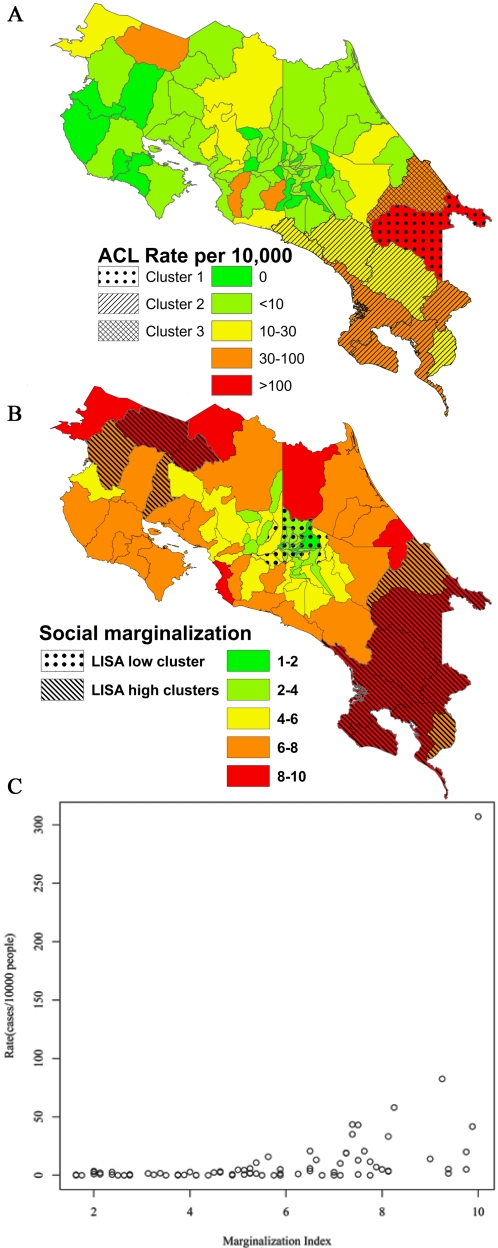
Patterns of clustering and Schmalhausen's law.(A) Quinquennial (1996–2000) cutaneous leishmaniasis case rates (cases/population) in Costa Rica at the county level. Colors indicate clustering in monthly rates per 10,000 inhabitants obtained using the Scan method: blue corresponds to the most likely cluster, comprised of the Talamanca county, with a monthly rate 308 per 10,000 from January 1999 to December 2000 (loglikelihood ratio = 3020.06, P<0.001); green depicts the second most likely cluster, comprised of the counties of Osa, Buenos Aires, Aguirre, Perez Zeledon, Golfito, Coto Brus, Aguirre y Corredores, with a rate of 7 per 10,000 from June 1996 to November 1999 (loglikelihood ratio = 515, P<0.001); and red corresponds to the third most likely cluster, comprised of the county of Limon with a rate of 12 per 10,000 from April 1997 to May 2000 (loglikelihood ratio = 265, P<0.001). (B) The county marginalization index (See Protocol S1 for details). Red and blue indicate clusters with high and low marginality, respectively, found using the LISA method with weights based on the 4 nearest neighbors (overall I = 0.7096, P<0.05). (C) County rate as a function of the marginalization index. Black dots represent counties with less than 2 cases in the five years. This pattern, which we call Schmalhausen's pattern, shows a significant positive correlation between marginality and the rate of the disease (r = 0.39, t = 3.8221, df = 79, P<0.0002), where a qualitative change in the relationship is apparent after and before a value of 4 in the marginalization index. Specifically, the variance increase for larger values of social marginalization, consistent with the prediction that new or anomalous conditions modify the system's sensitivity to other drivers.